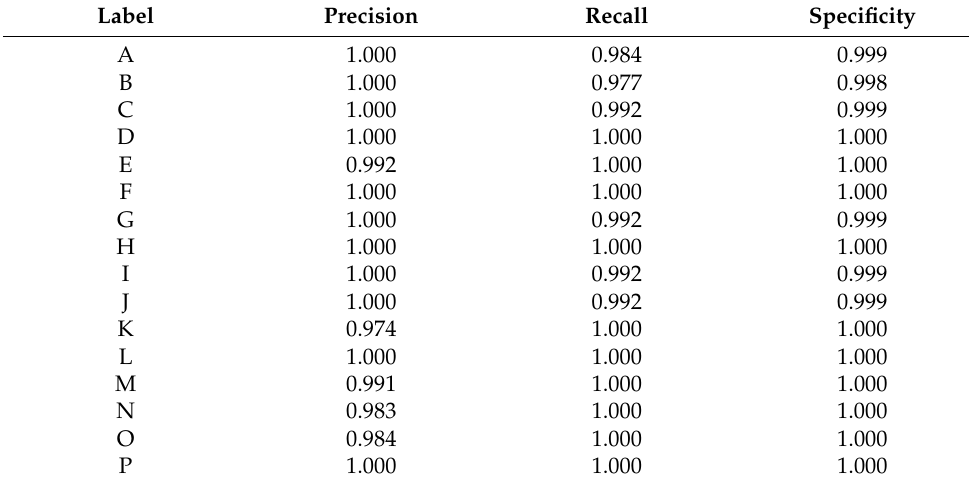
Table 5. Precision, recall and